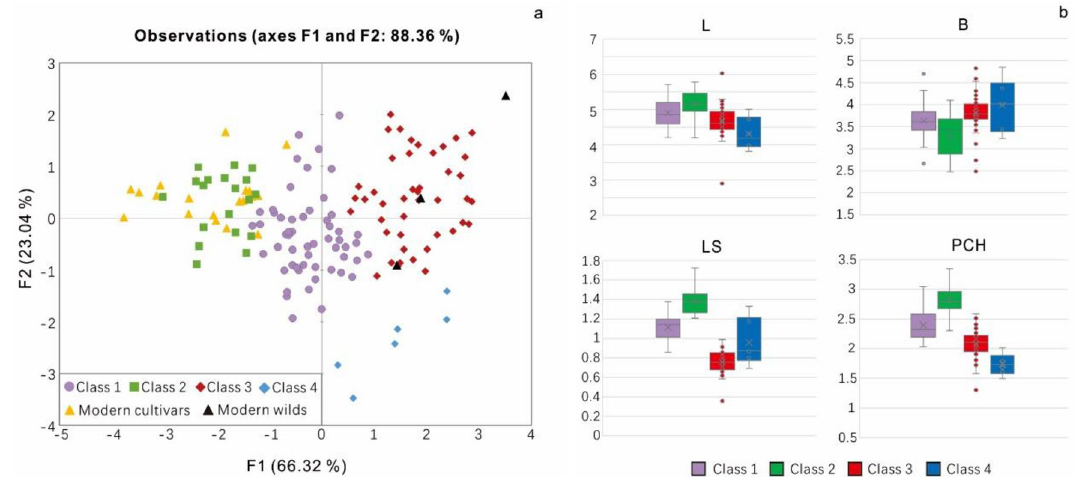
Figure 4. The results of PCA result of archeological grape pips from the Bronze Age in Central Asia and modern domesticated grape pips and parameter changes in each class. ( a ) PCA results based on centroid coordinates of PC1 and PC2 (Total variance 88.36%). ( b ) Mean and variance of L, B, LS, and PCH data in each class (PCA and LDA detail in EMS